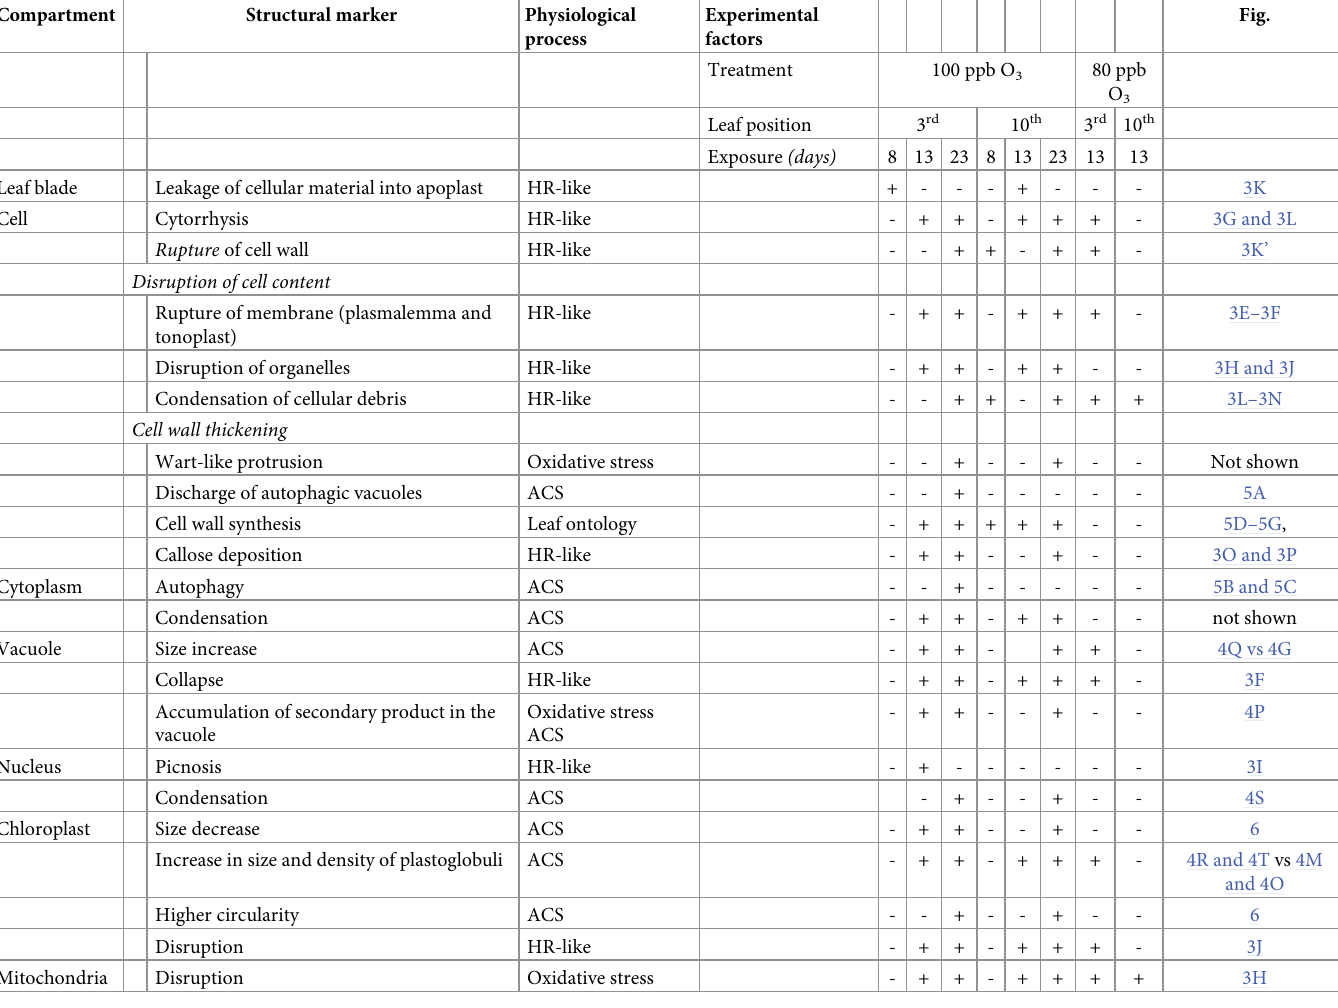
lution over time, with significant differences between the mesophyll layers. Primarily the Table 1. Development of structural and ultrastructural markers of O 3 stress over 30 days of exposure to the CF +100 ppb O 3 and CF +80 ppb O 3 treatment versus CF treatment, within the mesophyll of hybrid poplar leaves ( Populus x tremula alba ). Compartment Structural marker Experimental